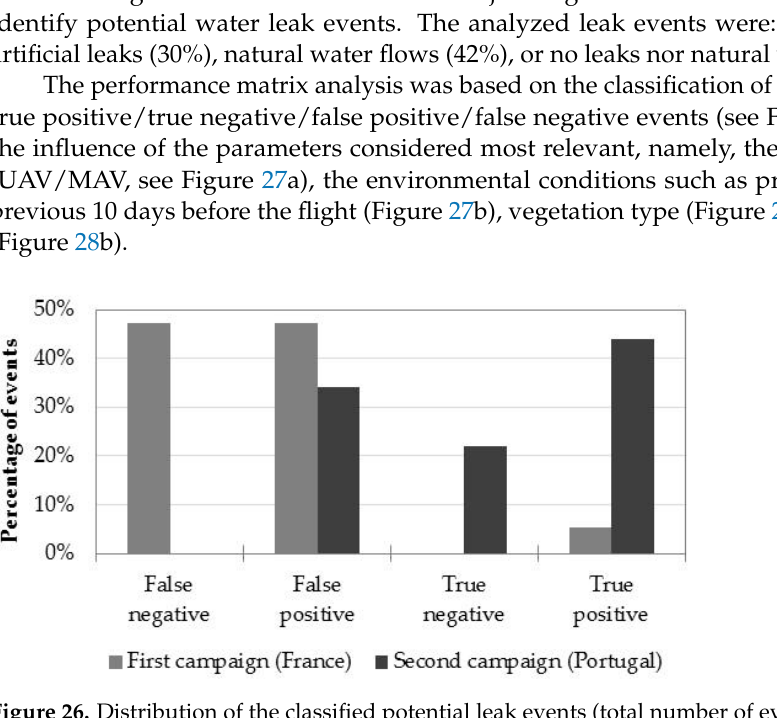
Figure 26. Distribution of the classified potential leak events (total number of events: 60).